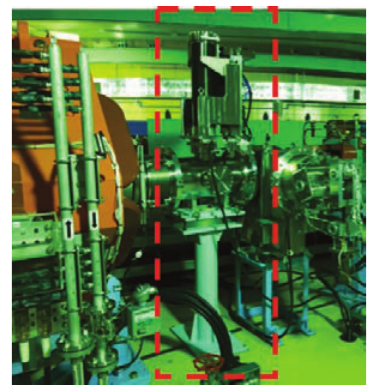
Figure 1. Vacuum chamber with GM cryocooler and sample mounted on movable stage or the measurement displacement cross section placed at the beamline shown in hatched line.